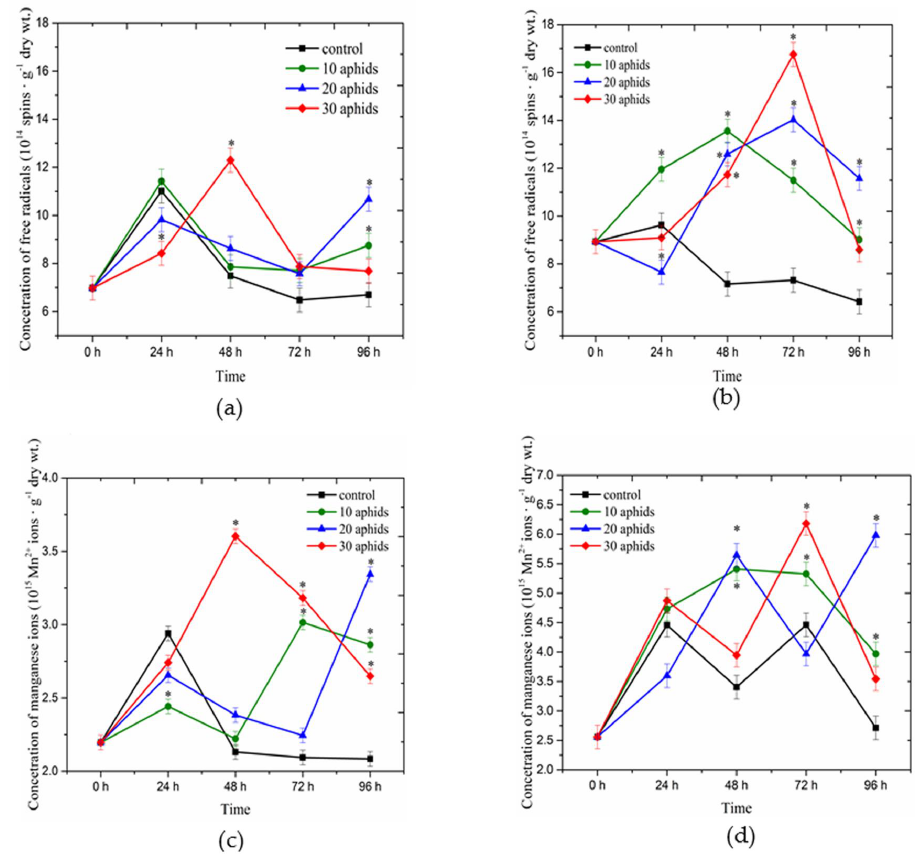
Figure 1. Concentrations of semiquinone radicals with two g -values: 2.0045 ± 0.0005 and 2.0026 ± 0.0005 ( a , b ); and manganese ions with g -values of 2.00 (0.01) ( c , d ) in leaves of one- and two-month-old plants of Asparagus officinalis L. cv. Argenteuil infested by Brachycorynella asparagi (Mordvilko) at a varied population size (10, 20, and 30 aphids per plant). Values represent means and SE from three independent experiments. The data was statistically analyzed using analysis of ANOVA variance ( p -values at α = 0.05). In individual figures significant differences are shown using